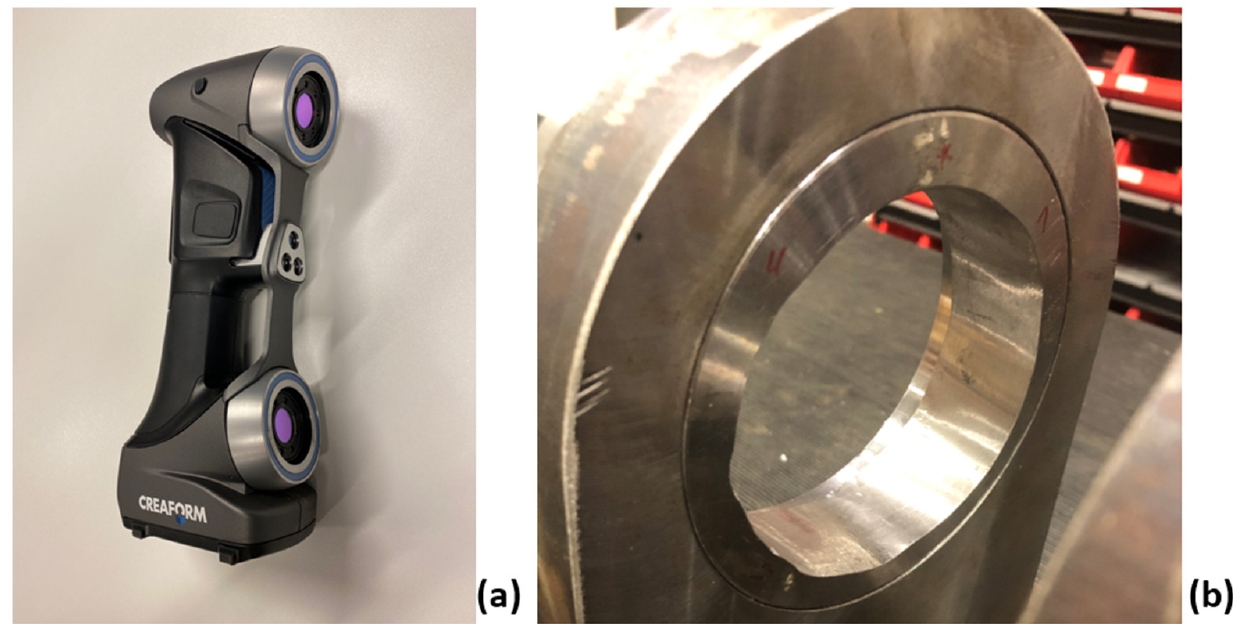
Figure 4. ( a ) Handheld 3D scanner, and ( b ) worn support.